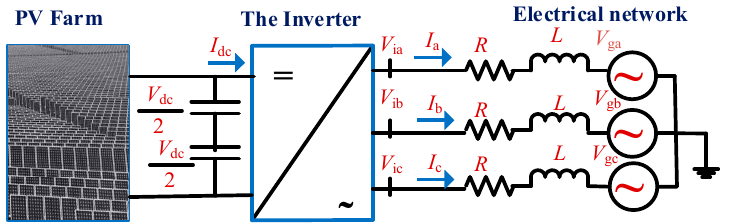
Figure 4. Three-phase (3-ph) view of the grid-connected voltage source inverter.